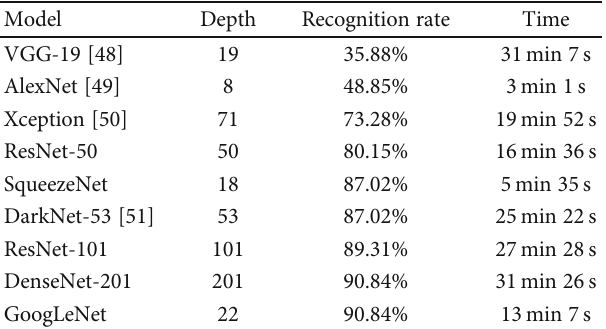
Table 1: Comparison table of target recognition e ff ect under di ff erent neural network transfer